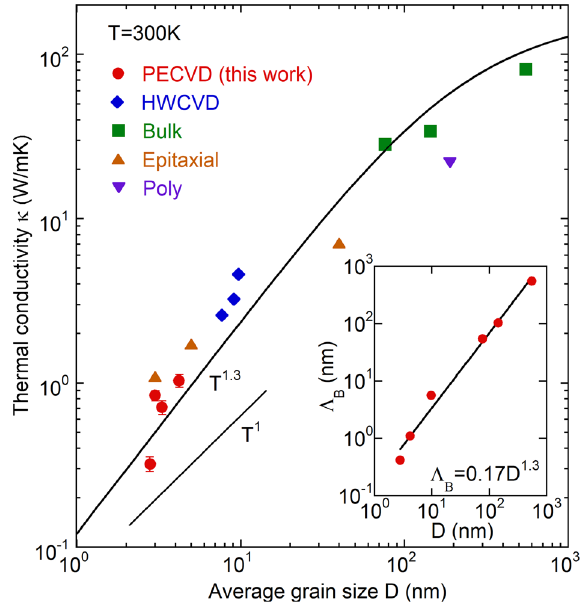
Fig. 7 The room temperature thermal conductivity vs. the average grain size D . The hot-wire chemical vapor-deposited nc -Si thin fi lms 29, 44 , the bulk nc -Si 27 , the polycrystalline silicon 28 , the epitaxial nc -Si 40 , and the plasma-enhanced chemical vapor-deposited nc -Si thin fi lms presented in this work are compared. The solid curve is the result of the Born-von Karman model calculation using the empirical superlinear D -dependent phonon mean-free path shown in the inset and explained in the “ Analytical modeling ” section. It is in contrast to the reference line labeled T 1 at the small D end. The error bars for plasma-enhanced chemical vapor-deposited nc -Si fi lms are given (unless they are smaller than the data points), as discussed in detail in Supplementary Note